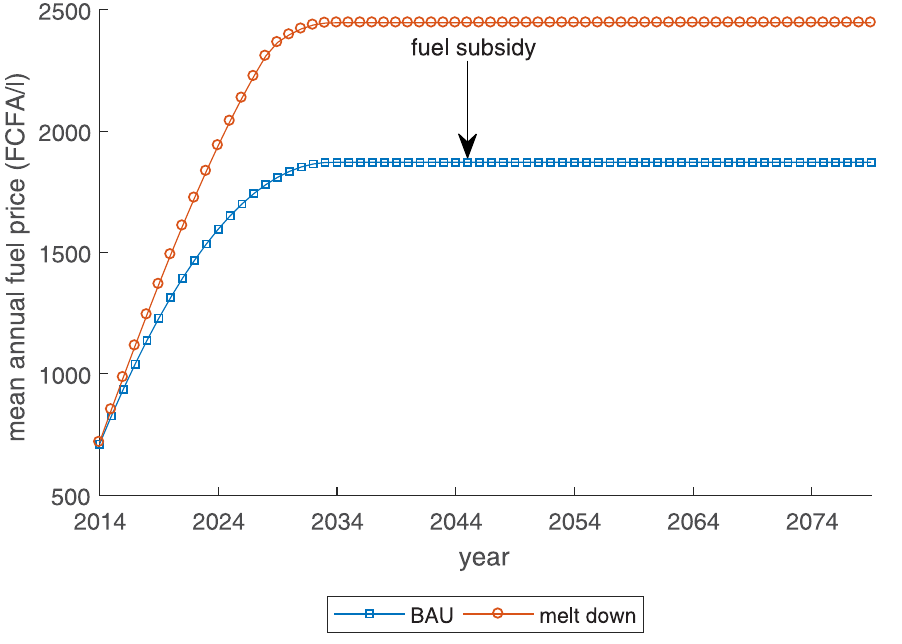
Fig 3. Mean annual fuel price development under different fuel price